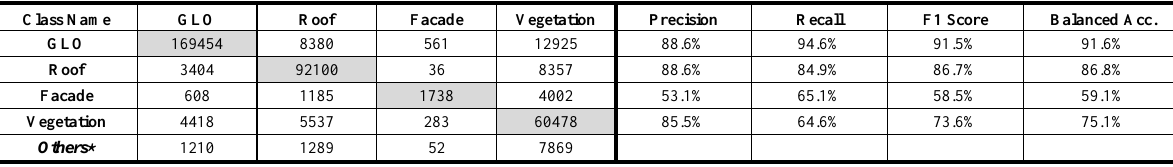
Table 4. Confusion Matrix and per-class accuracy for 4-class classification. Others* include points from powerline, cars and fence, which are classified as GLOs, roof, façade or